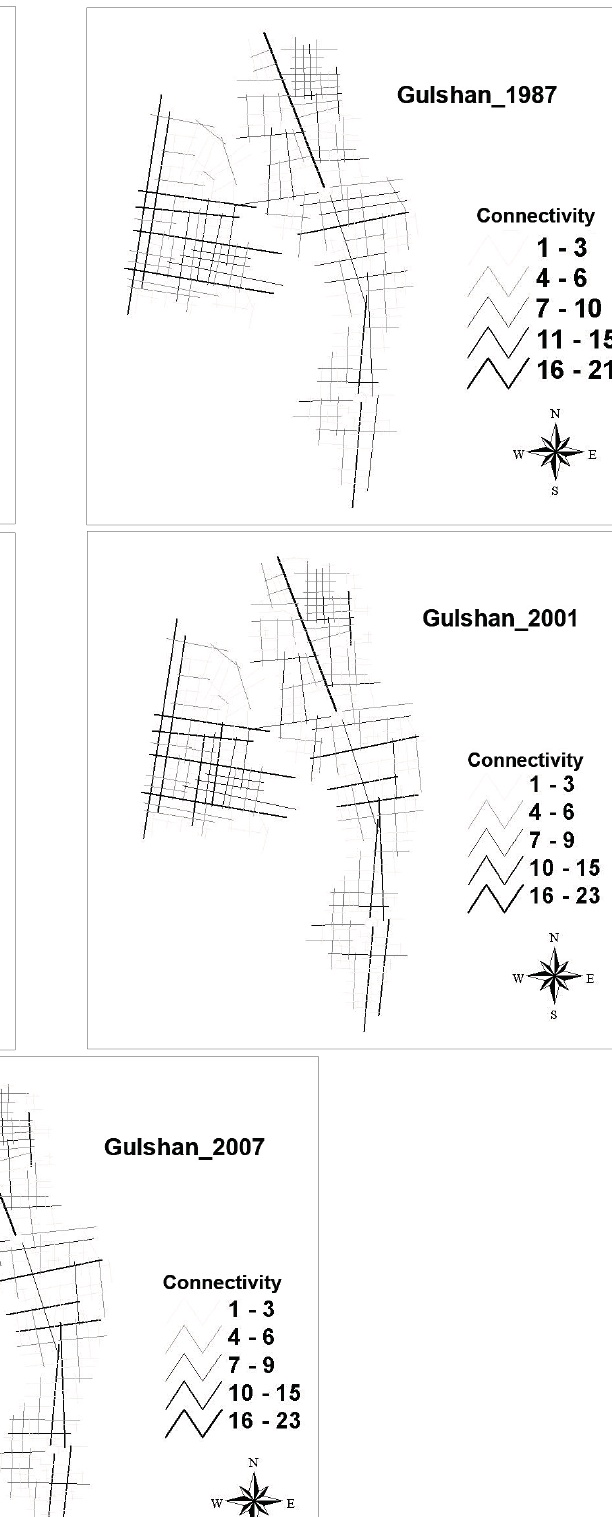
Figure 10. Connectivity maps of ward 19 (Gulshan) in different time periods (not to